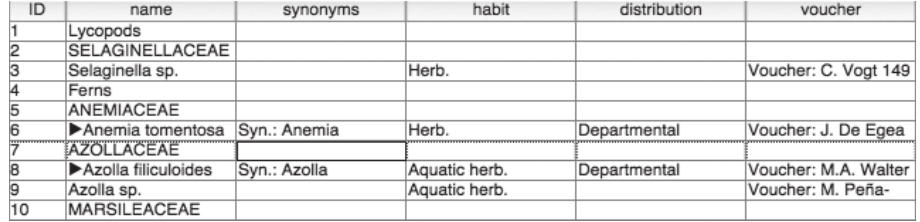
Figure 5. Example of a scientific name